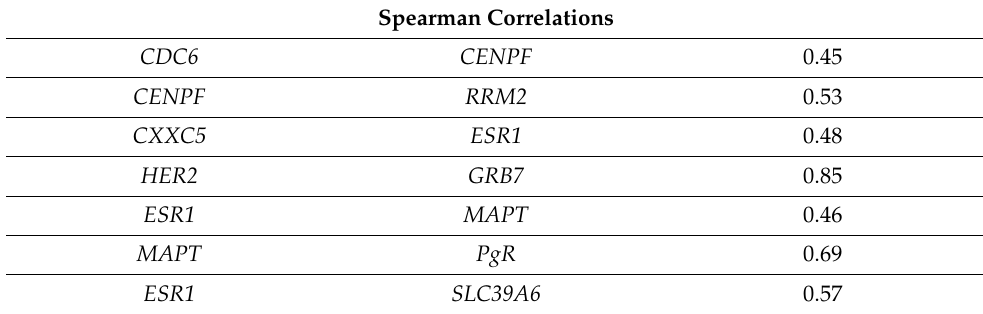
Table 3. Spearman correlations exceeding 0.4 among gene expression measurements of Table 2.